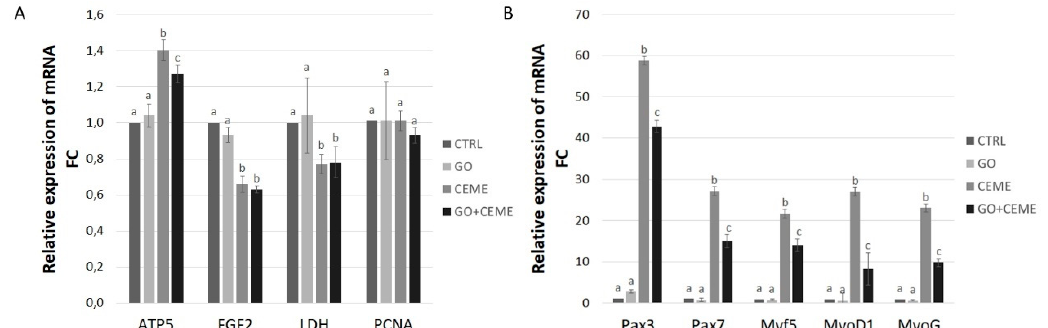
Figure 6. Real-Time PCR analysis of gene expression at the mRNA level in muscle progenitor cells from the chicken embryo after 5 days of primary culture. Expression of genes related to proliferation, basic metabolism ( A ), and muscle cells differentiation ( B ) was investigated; the figure shows the results for the control group ( CTRL ), cells cultured on GO nanofilm (GO), cells cultured with addition of the extract (CEME), and cells cultured on GO nanofilm and extract (GO + CEME); Relative expression was calculated using housekeeping genes, ACTB and GAPDH; the results are presented as 2- ΔΔ CT values compared to the control group; different letters above the columns indicate statistically significant differences between the groups ( p ≤ 0.05). The error bars represent standard deviations.